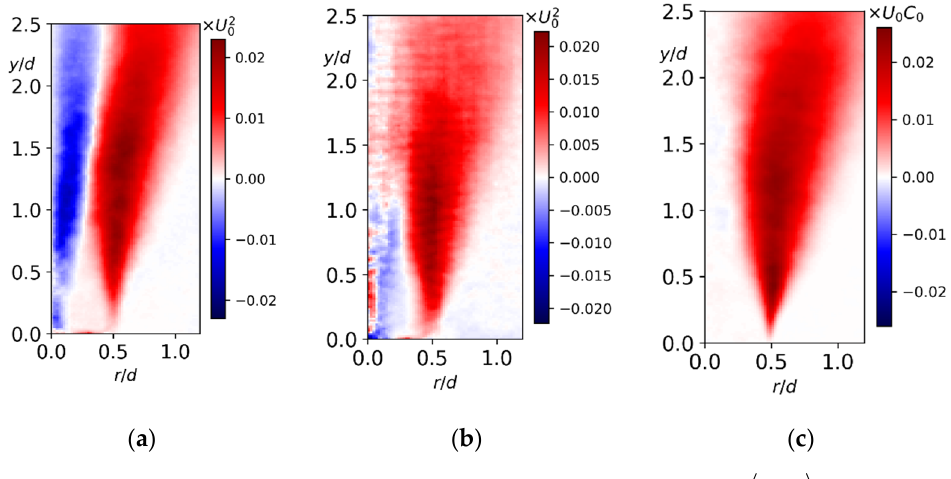
(cid:68) (cid:69) (cid:10) (cid:11) u (cid:48) r u (cid:48) y u (cid:48) r u (cid:48) , ( b ) , and θ